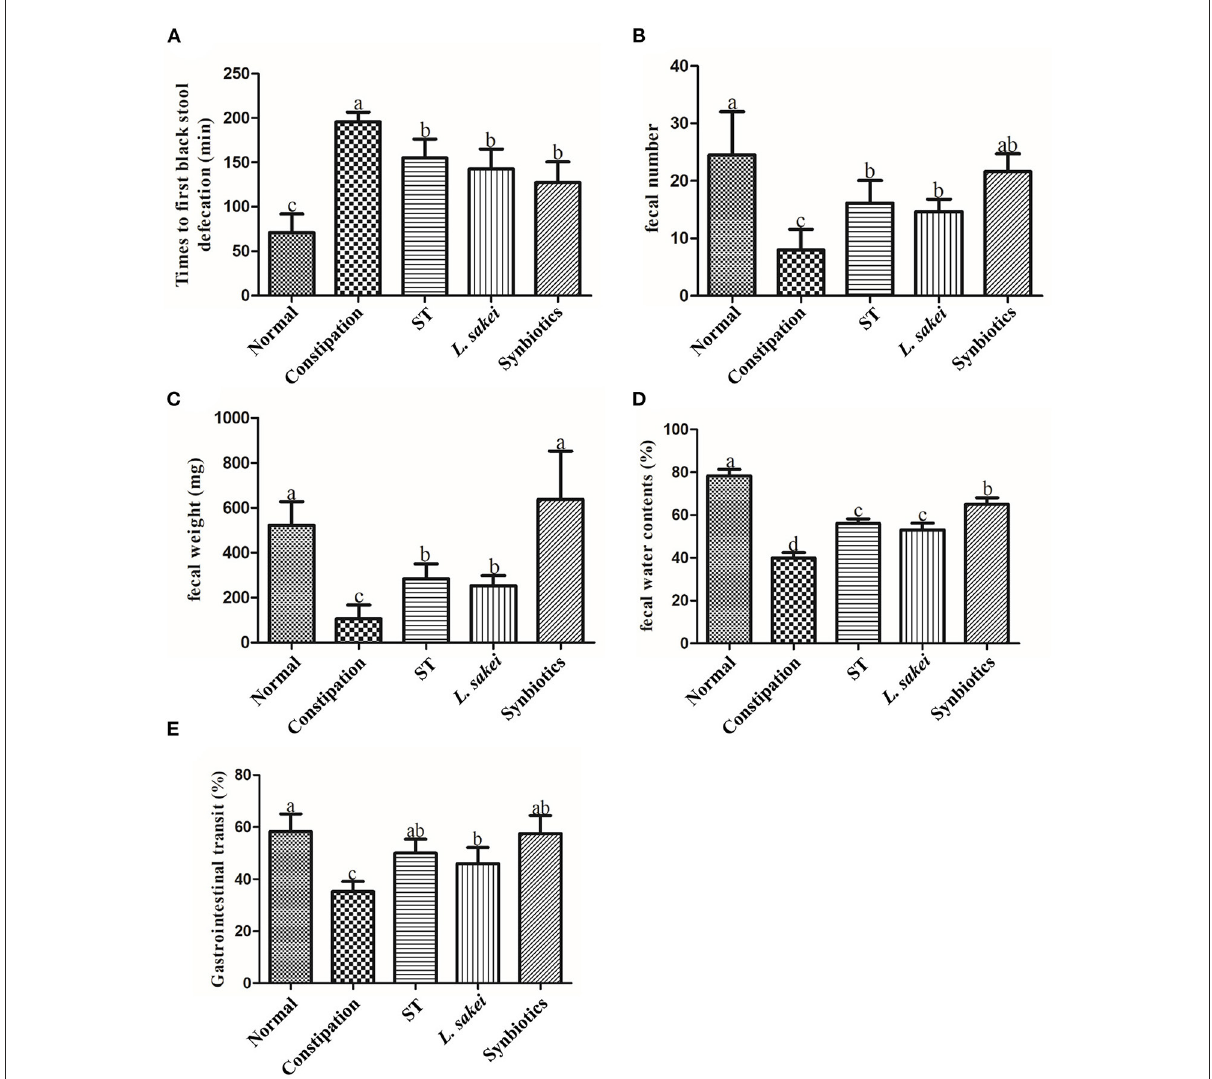
FIGURE1 Effects of ST or L. sakei alone or combined on defecation parameters and gastrointestinal transit in mice. (A) Times to first black stool defecation; (B) Fecal number; (C) Fecal weight; (D) Fecal water contents; (E) Gastrointestinal transit. Data represent the mean ± SD ( n = 6). Statistical analysis was conducted using One-way ANOVA followed by Tukey’s multiple comparisons test for each group. The bars bearing different letters indicate a significant difference, P <